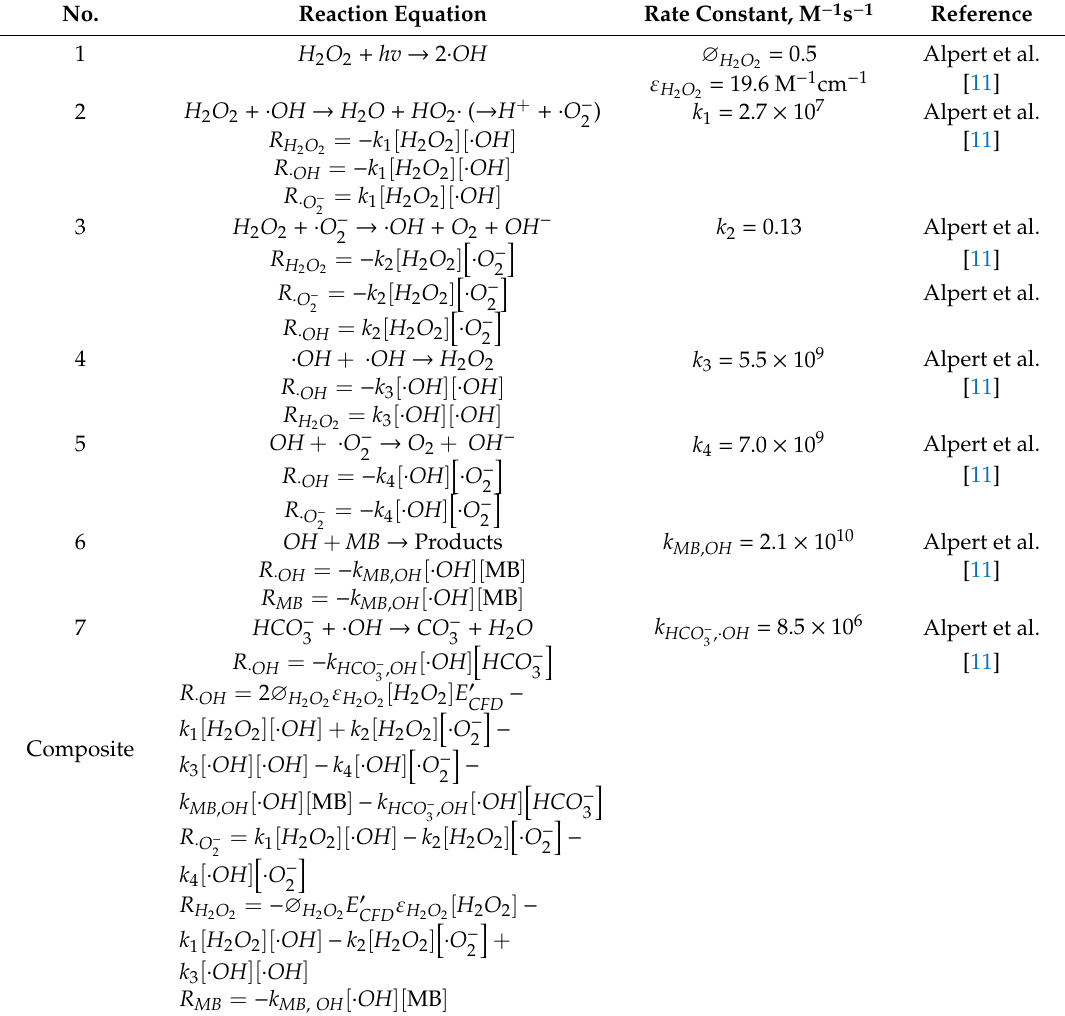
Table 1. Kinetic model of UV / H 2 O 2 advanced oxidation of